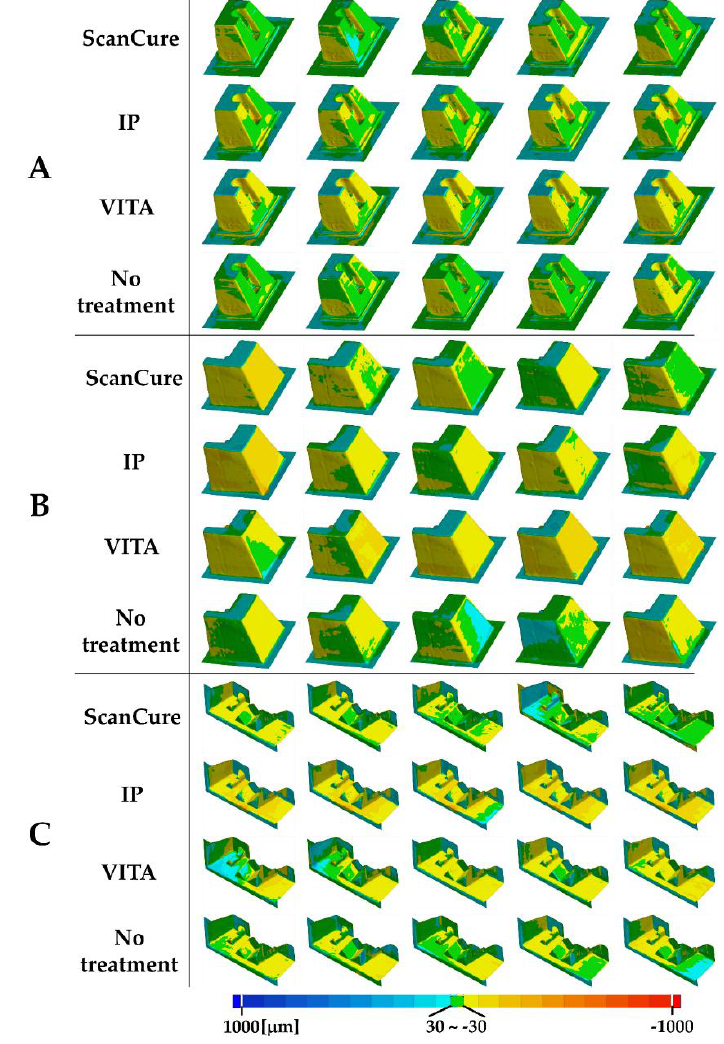
Figure 3. Superimposed error distribution for four experimental groups in the reference models. ( A ) inlay model, ( B ) onlay model, ( C ) bridge model (tolerance range ± 30 µm, respectively).